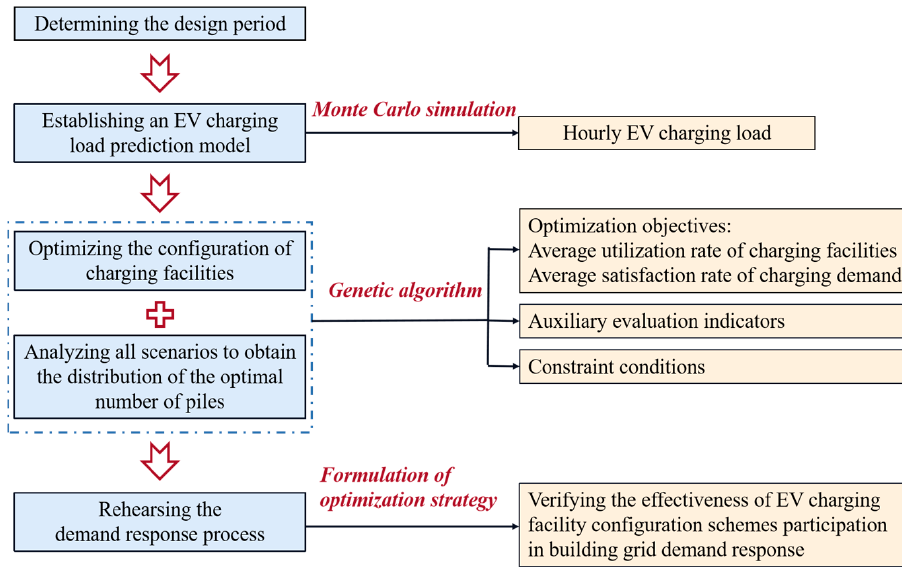
Figure 1. Research framework.